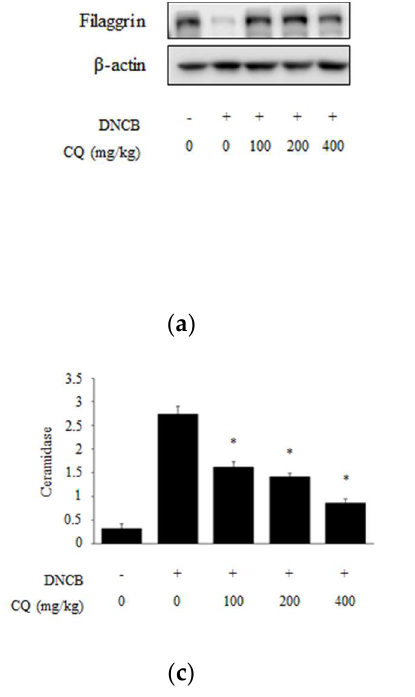
Figure 6. The expression of filaggrin and ceramidase on dorsal skin lesions in DNCB-induced BALB/c mice. ( a ) To demonstrate the effect of CQ in DNCB-induced BALB/c mice, the tissue was collected, homogenized, and lysed in lysis buffer at the end of the experiment. The expression of filaggrin was analyzed by Western blotting; ( b ) The relative expression level of filaggrin was measured using an image analyzer; ( c ) The level of ceramidase was analyzed with ELISA. The mice were randomly divided into five groups: normal, DNCB, and DNCB + CQ (100, 200, and 400 mg/kg) for 6 weeks. All data are presented as mean ± SD; # p < 0.05 vs. normal group, * p < 0.05 vs. DNCB-induced group.